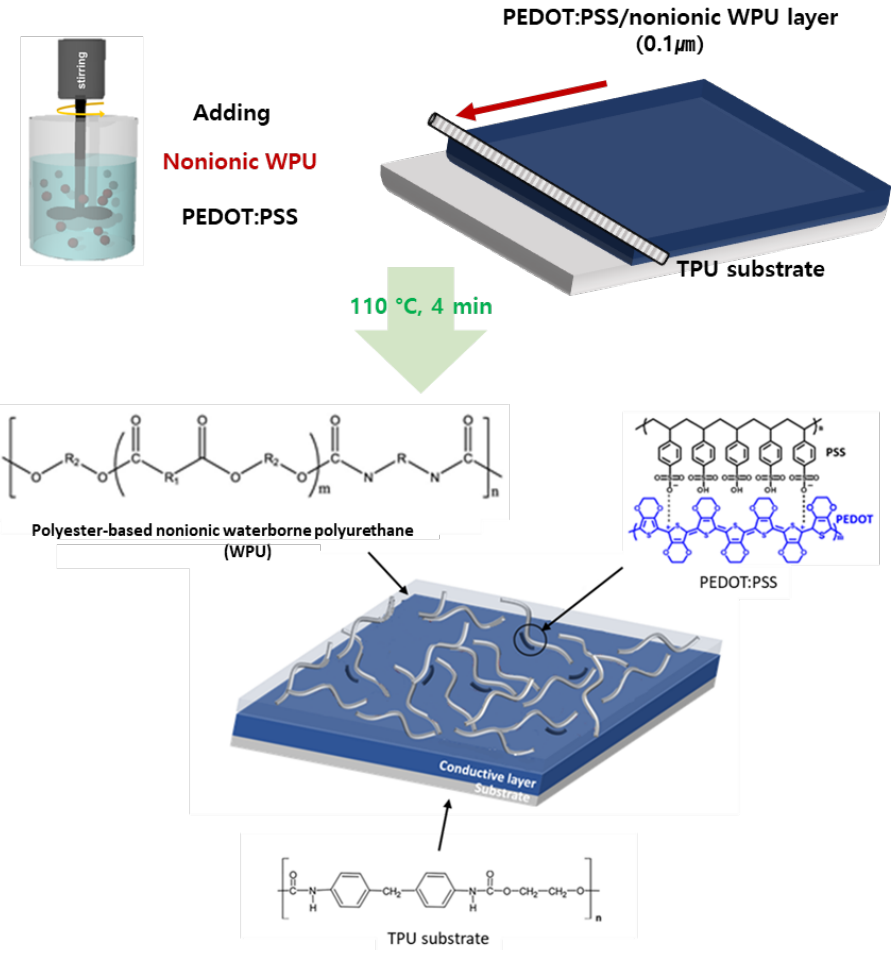
Figure 1. Fabrication Process and Structure of Stretchable Electrode Film. (In WPU, R, R1, and R2 indicate different alkyl or aryl groups).